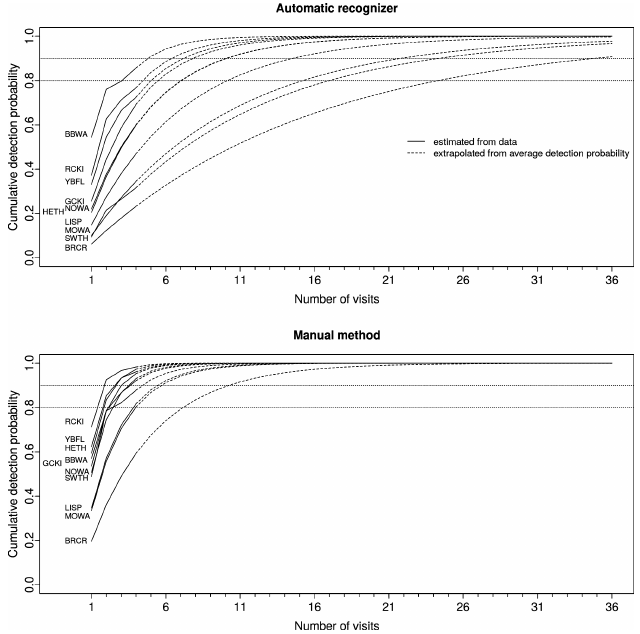
Fig. 4 . Cumulative probability of detecting the species at least once with a given number of visits computed from model- averaged estimates of detection probability for the automatic song recognizer and manual methods. The first four cumulative detection estimates were computed using the estimates for each visit based on the data and models (solid line). The later visits (dotted line) were computed using the equation 1-(1-p)^t, where p was the average detection probability derived from for the first four visits. Although we processed 350 to 630 minutes of recordings using the automated recognizers, we could not use this data to build cumulative detection past 4 visits because the recorded sample was processed as a single long recording rather than individual 10-minute recordings. Each species name appears next to its curve. See Table 4 for species